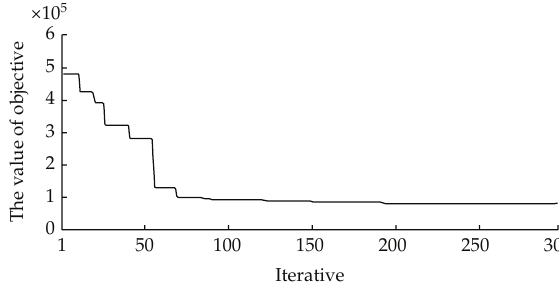
Figure 8: The variation curve on the objective with iterations.